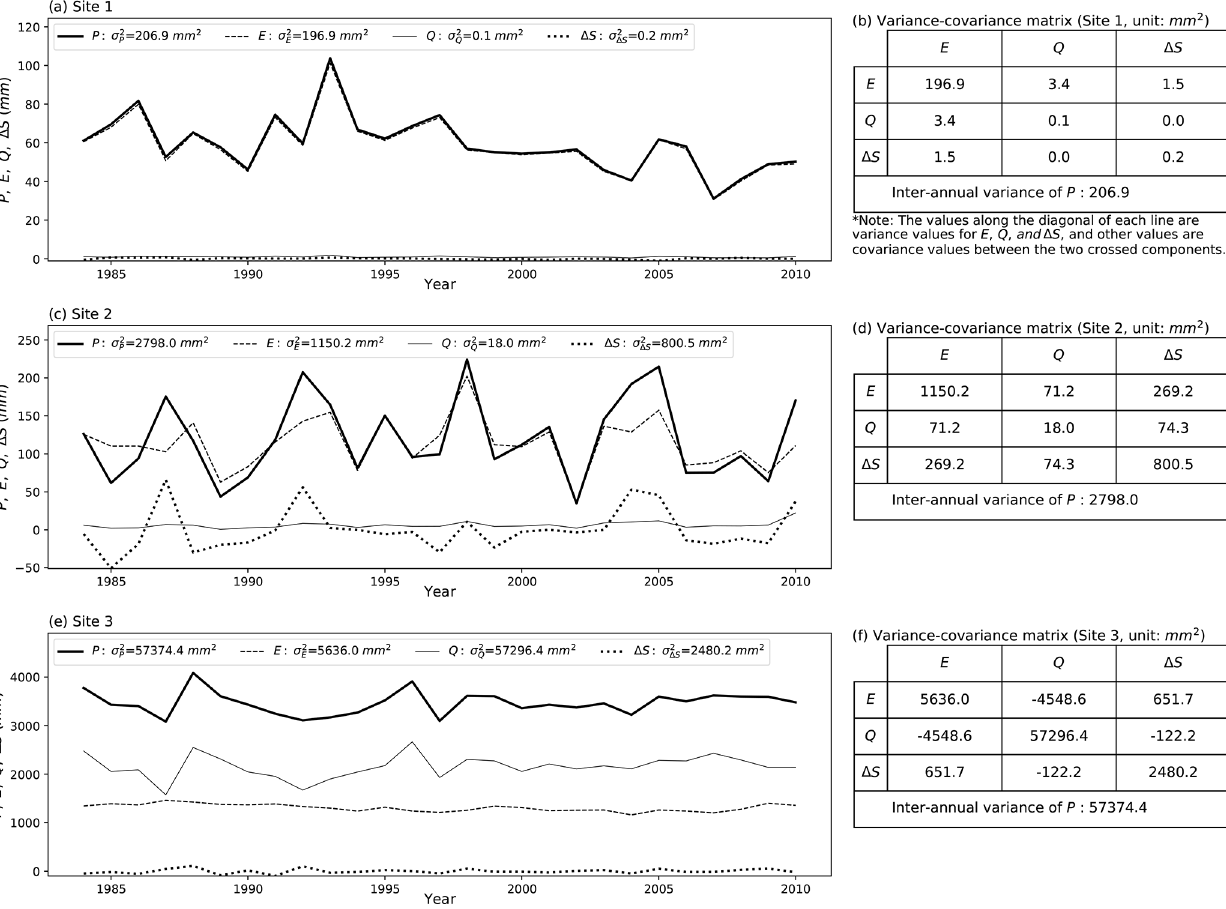
Figure 10. Inter-annual time series ( P , E , Q and (cid:49)S ) and the associated variance-covariance matrix ( E , Q and (cid:49)S ) for case study Sites 1– 3. Left column shows time series for (a) Site 1, (c) Site 2 and (e) Site 3, with right column, i.e. panels (b) , (d) and (f) , the associated variance–covariance matrix for three sites. Note that the covariance values in the tables should be multiplied by two to agree with the variance–covariance balance in Eq.